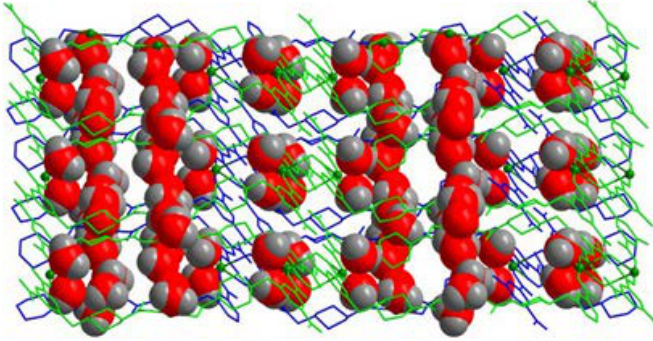
Figure 5. 3D supramolecular architecture with voids occupied by coordinated water molecules highlighted in space-filling. Table 1. Selected bond lengths (Å) and bond angles ( ° ) for 1 .